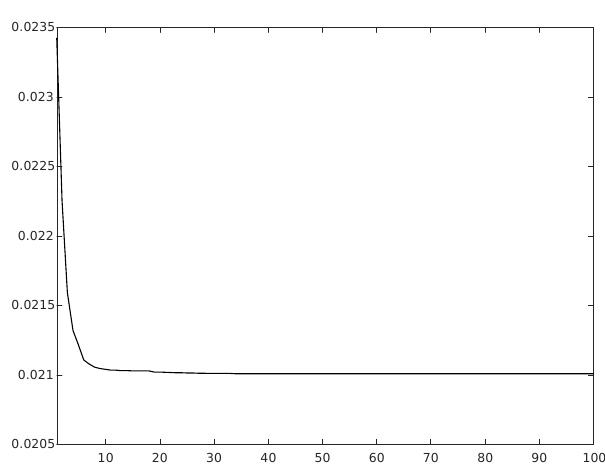
Figure 4. Approximated optimal control. Figure 4: Approximated Optimal Control